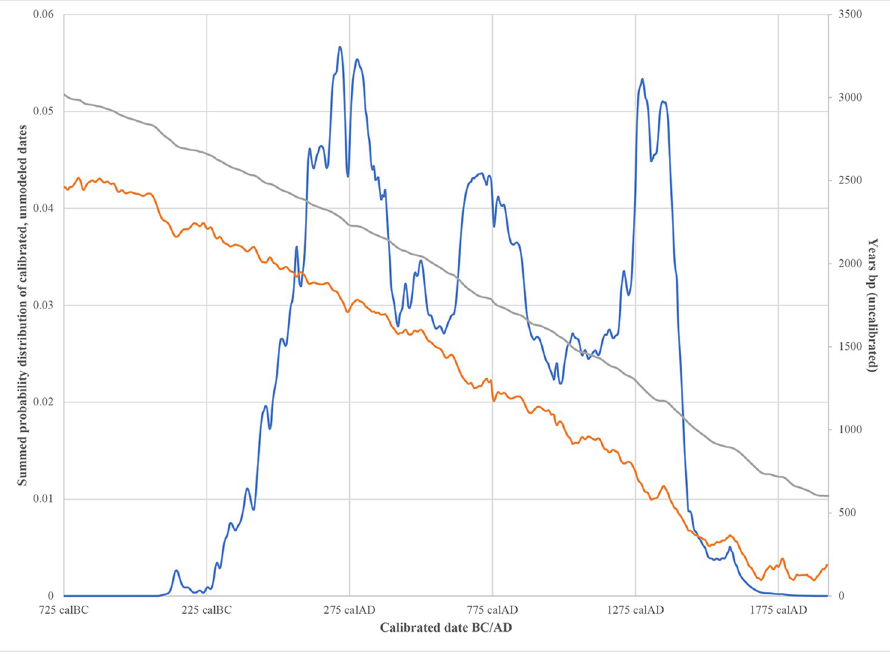
Fig 8. Trimodal distribution of La Hueca radiocarbon dates. Blue line represents summed probability distribution of all calibrated (but unmodeled) La Hueca radiocarbon dates. Orange and grey lines are Intcal20 and Marine20 calibration curves, respectively, presented to make clear that three peaks of combined La Hueca dates are consequence of actual distribution of dates, not an artifact of calibration.